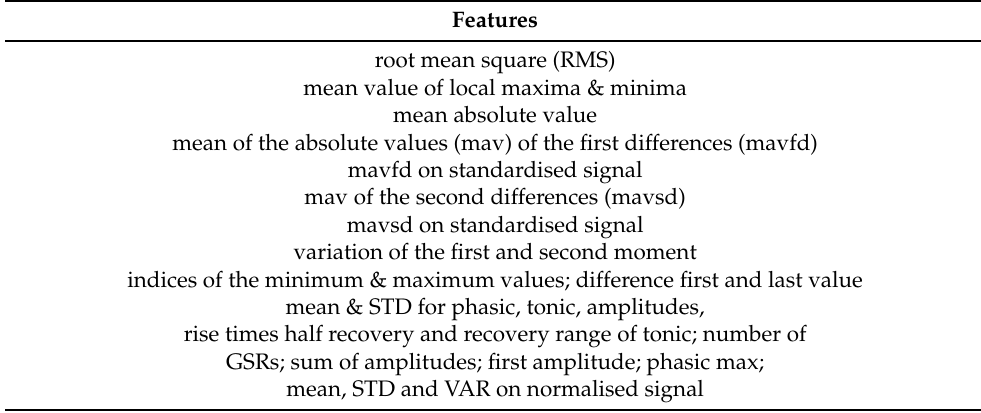
Table 1. Features computed for the EDA signal.